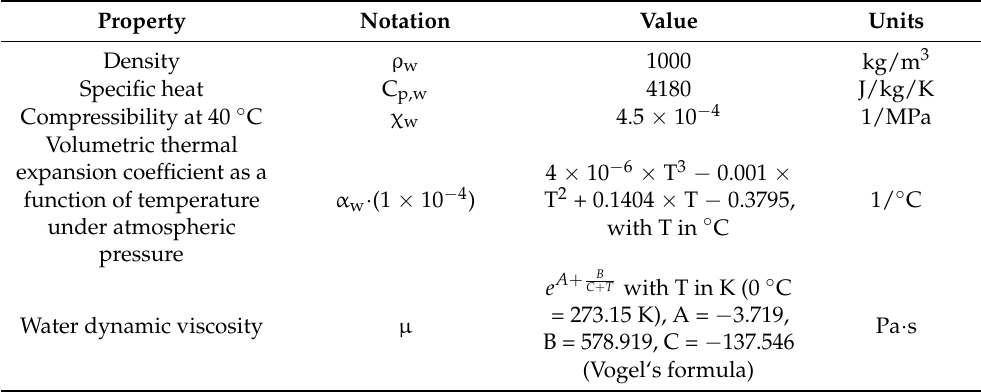
Table 3. Water properties.